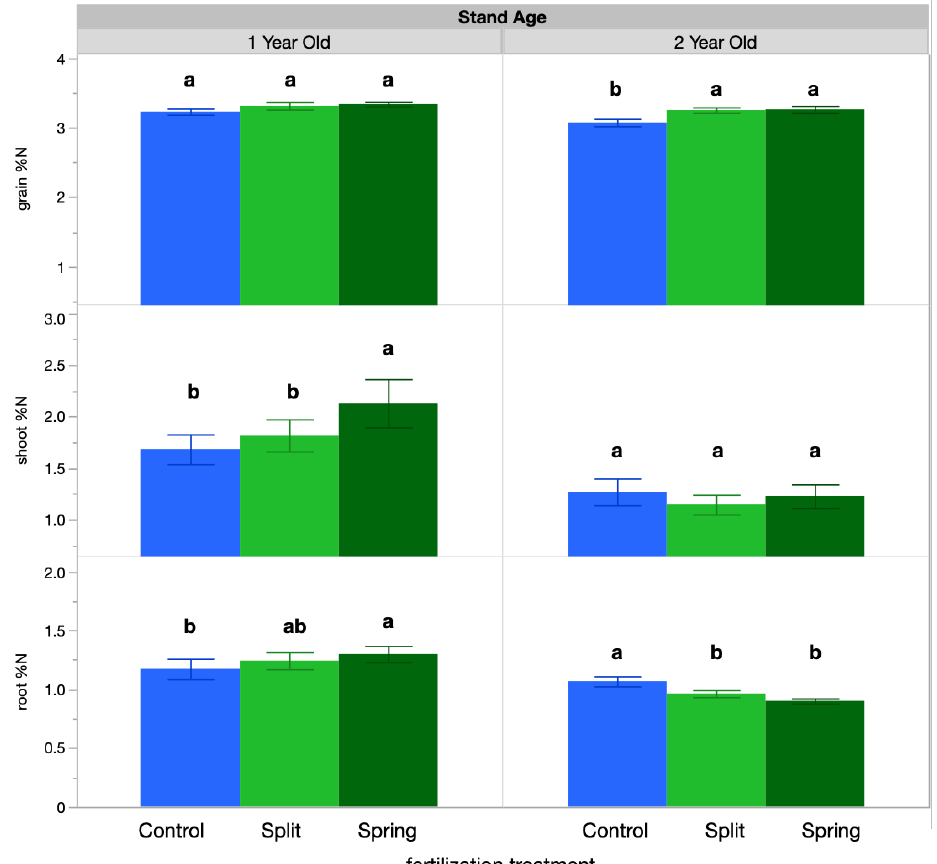
Figure 1. Tissue percent N results by treatment. Percent N values for each treatment were averaged across sample timepoints. Within each stand age, bars with the same or no letter are statistically similar, as per Tukey’s HSD ( p = 0.05).